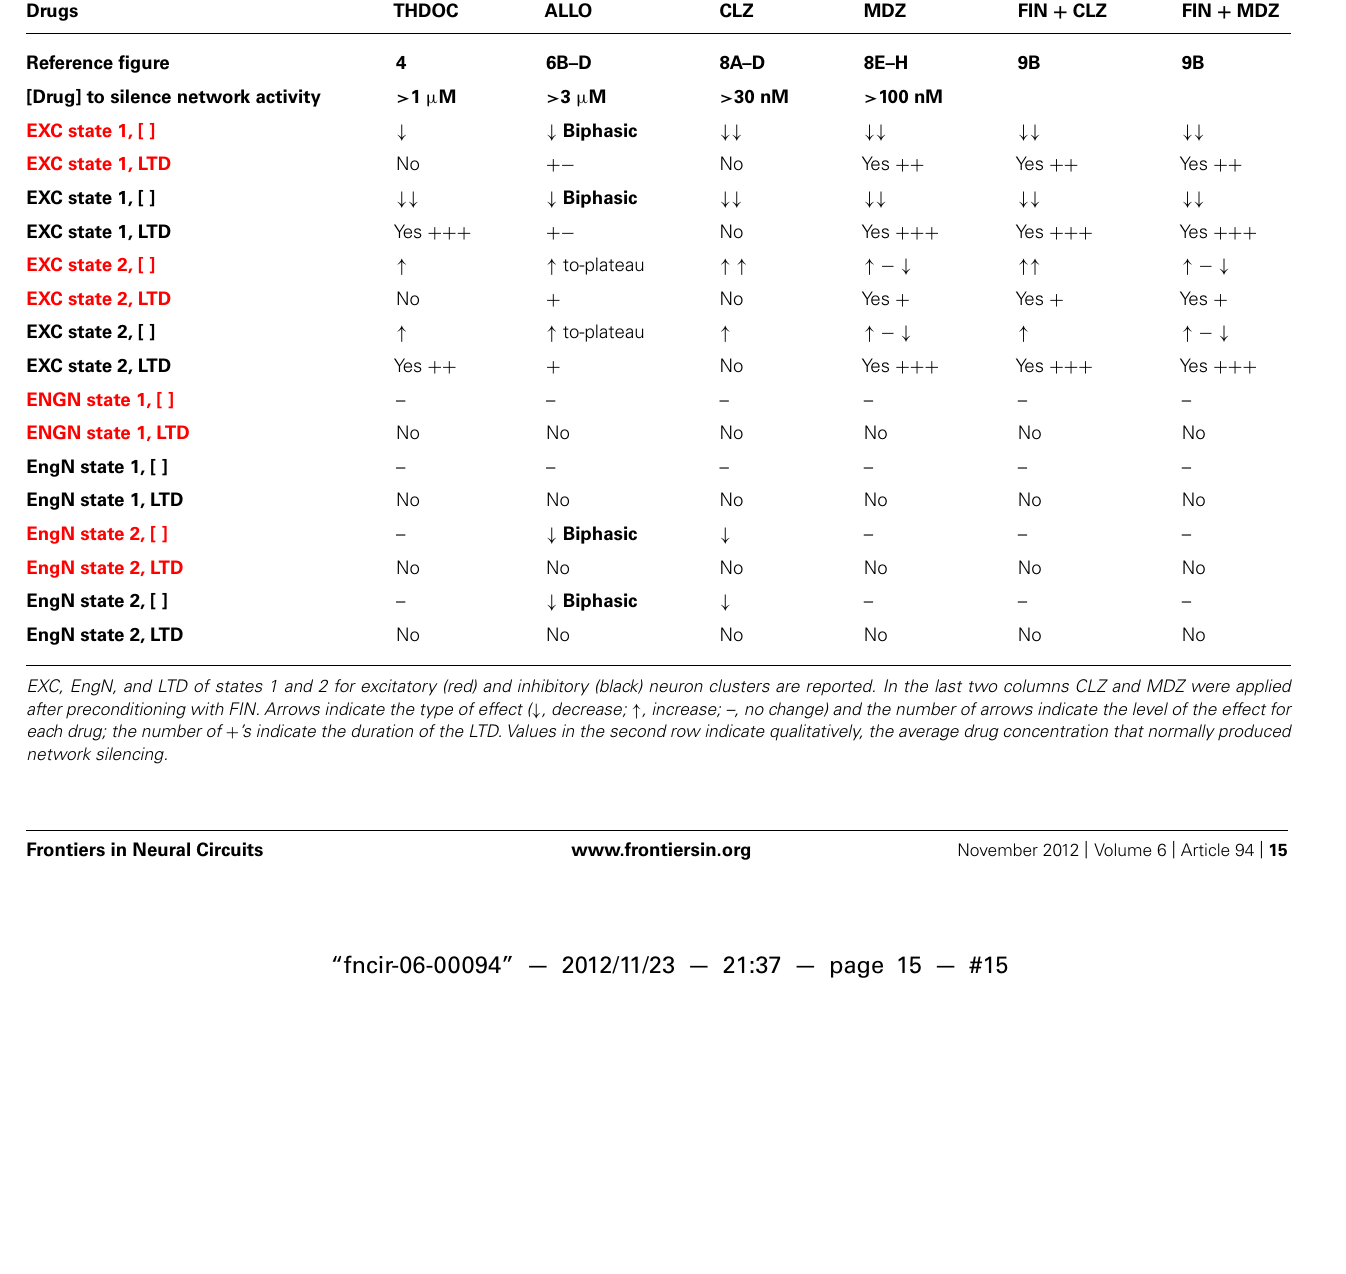
Table 1 | Effects of NSs (THDOC,ALLO) and BDZs (CLZ, MDZ) on excitability (EXC), engaged neurons (EngN), and long-term depression (LTD). Drugs Reference